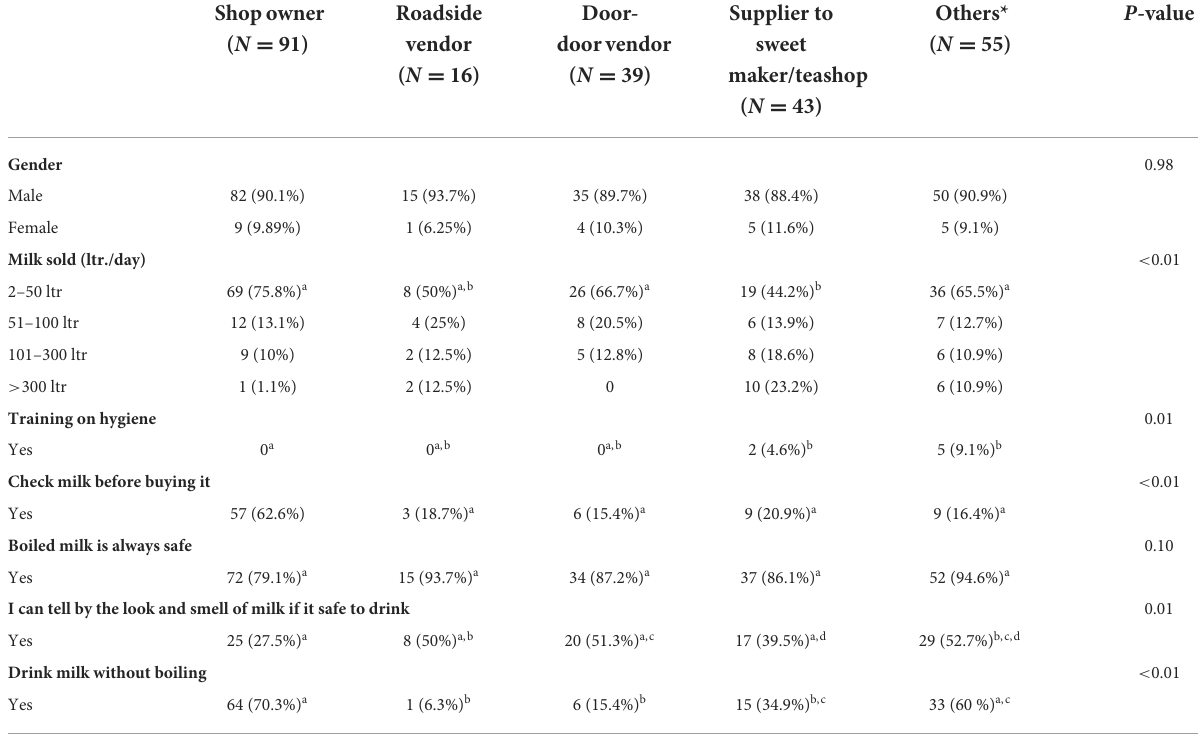
TABLE 1 Distribution of demographics, knowledge and practice among categories of milk vendors in Assam and Haryana, India.